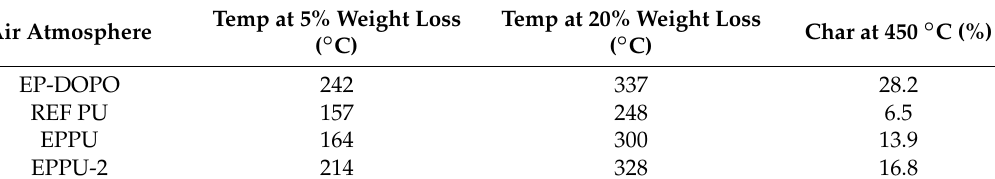
Table 3. Thermal degradation temperature of polyurethanes obtained with TGA (air).